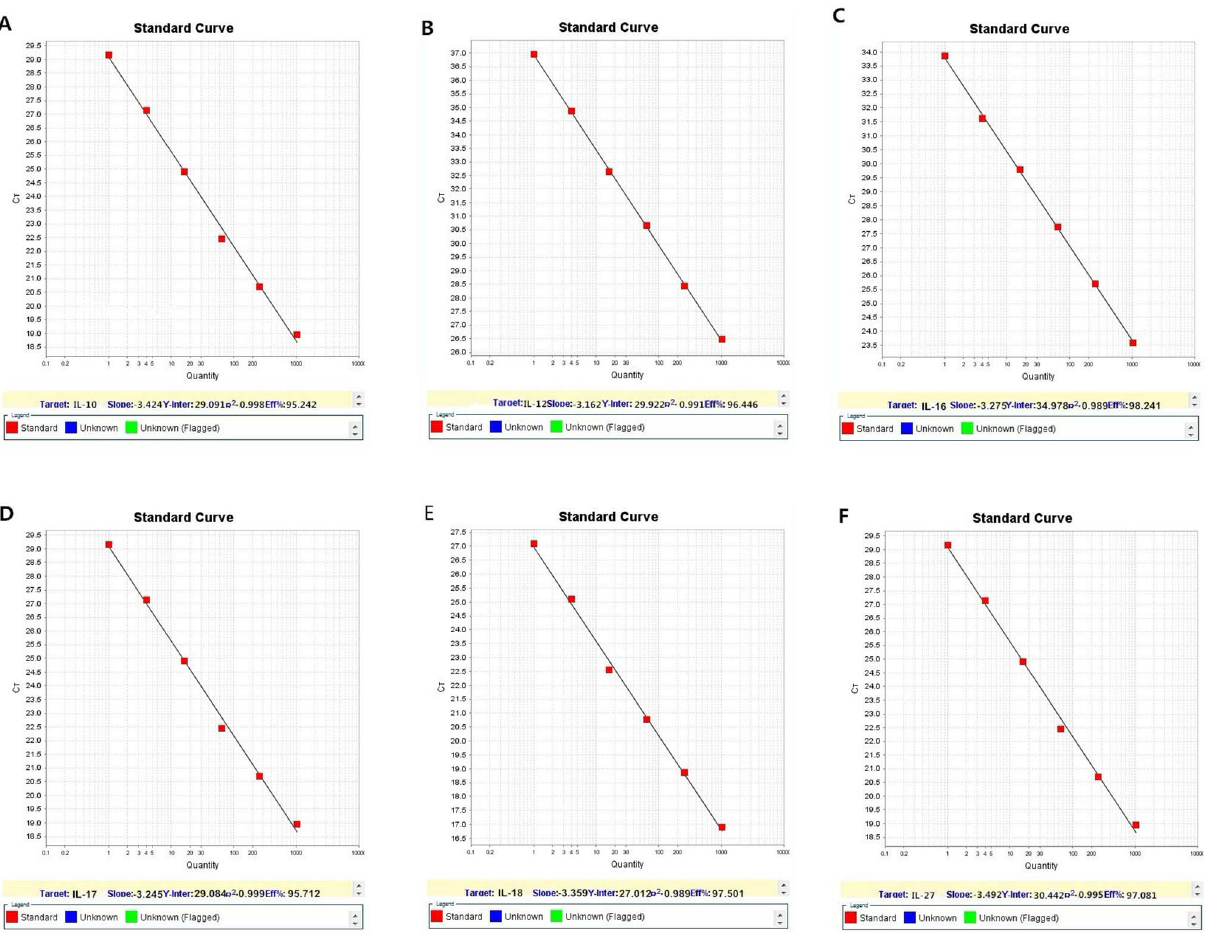
Figure 3. Standard curves. A: IL-10, the efficiency was 95.242% and the correlation coefficient was 0.998; B: IL-12, the efficiency was 96.446% and the correlation coefficient was 0.991; C: IL-16, the efficiency was 98.241% and the correlation coefficient was 0.989; D: IL-17, the efficiency was 95.712% and the correlation coefficient was 0.999; E: IL-18, the efficiency was 97.501% and the correlation coefficient was 0.989; and F: IL-27, the efficiency was 97.081% and the correlation coefficient was 0.995.